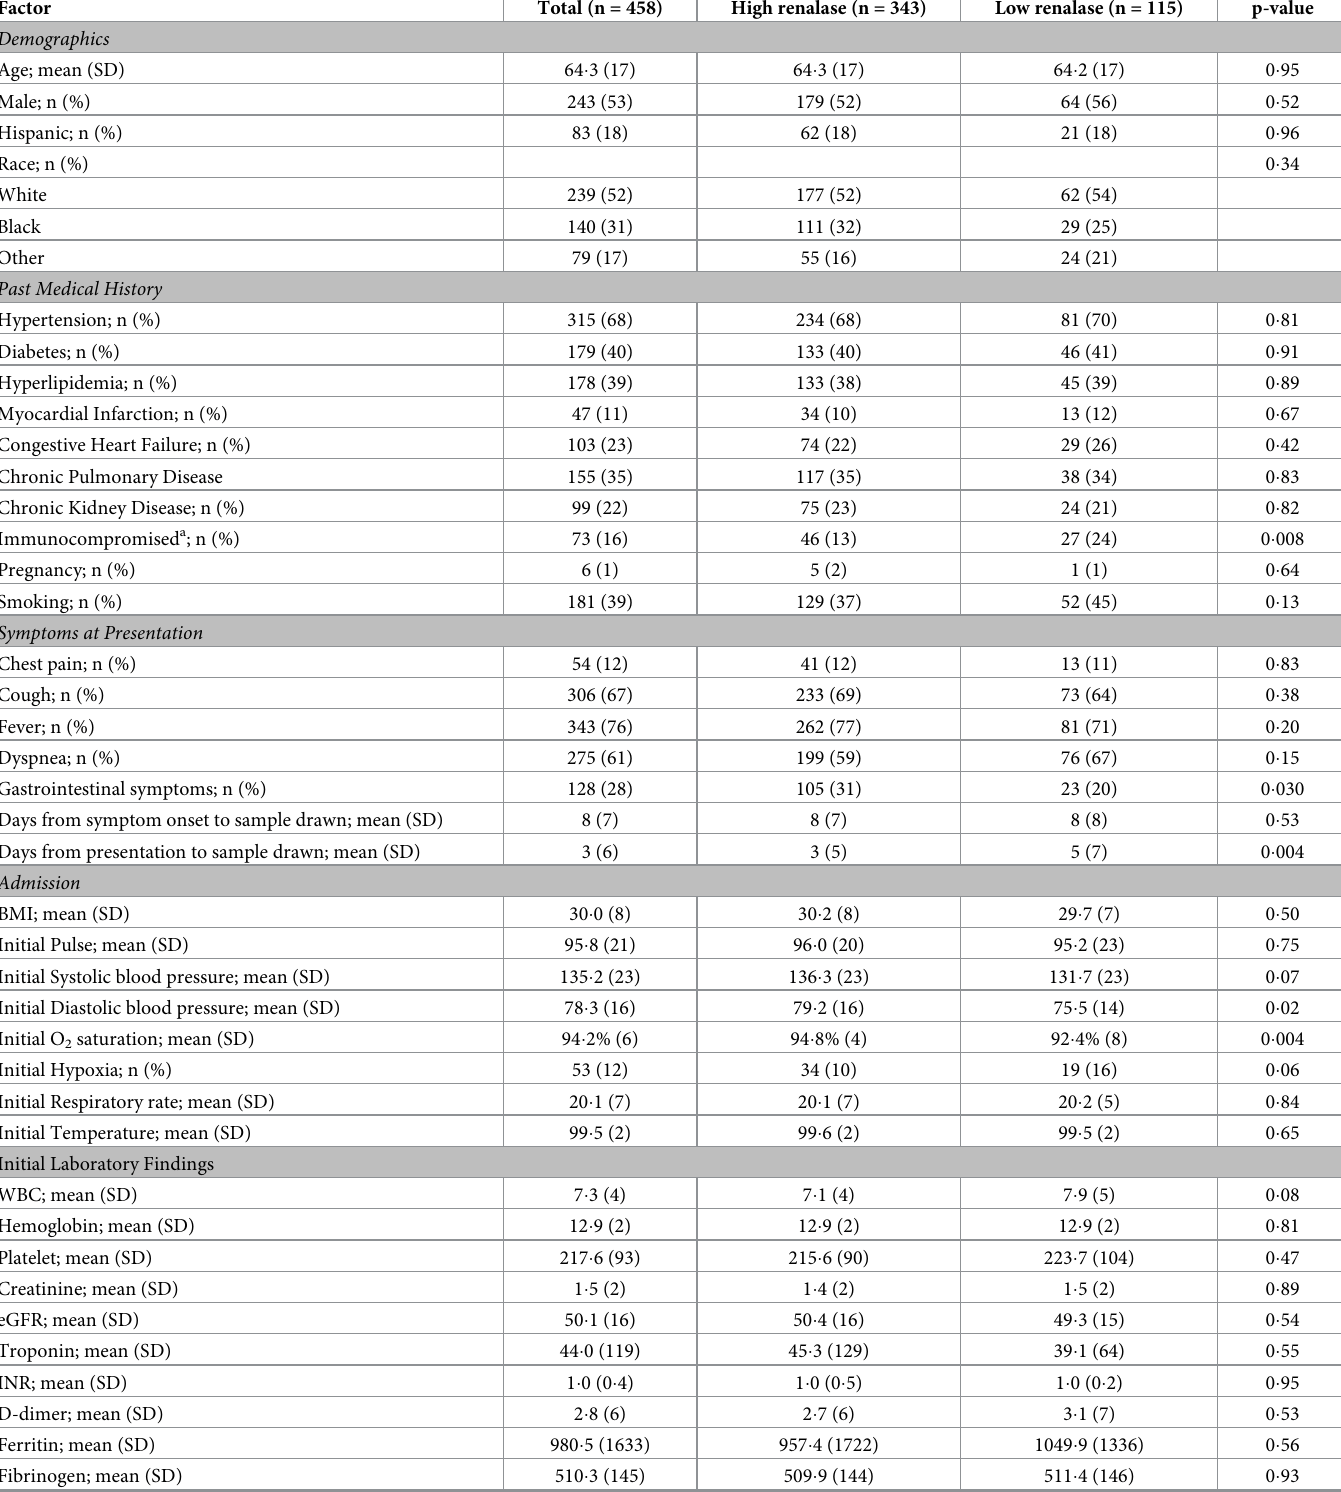
Table 1. Baseline clinical profile of hospitalized COVID-19 patients with low and high